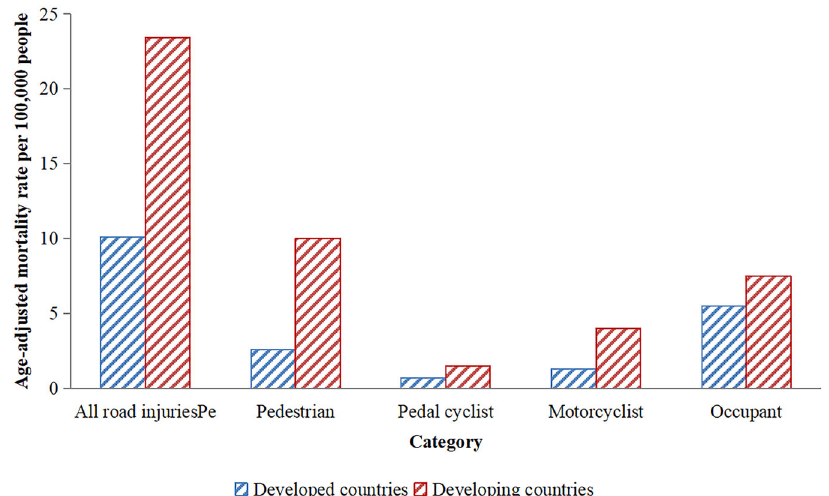
Fig. 3 Age-adjusted road injury death rate per 10,000 population by development statues and type of road users inthe Decade of Action for Road